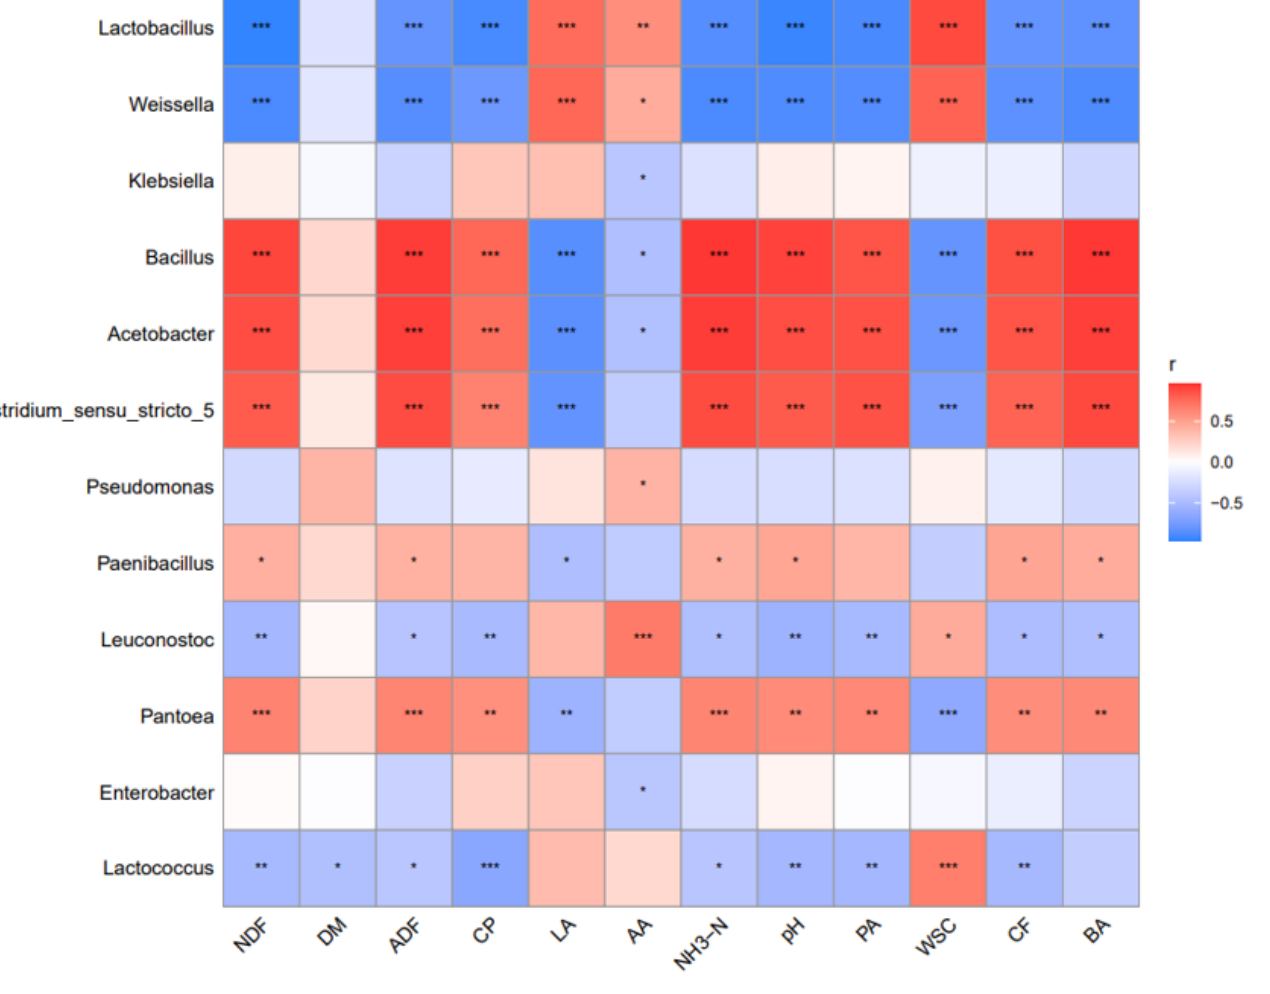
Figure 7. Correlational analysis between chemical composition and bacterial community at the genus level. The heatmap is the Spearman correlation coefficient r ( − 1 to 1). A value over 0 means there is a negative correlation (blue), and a value below 0 means there is a positive correlation (red), Asterisks: * denotes significant difference ( p < 0.05); ** denotes significant difference ( p < 0.01); *** denotes significant difference ( p < 0.001).